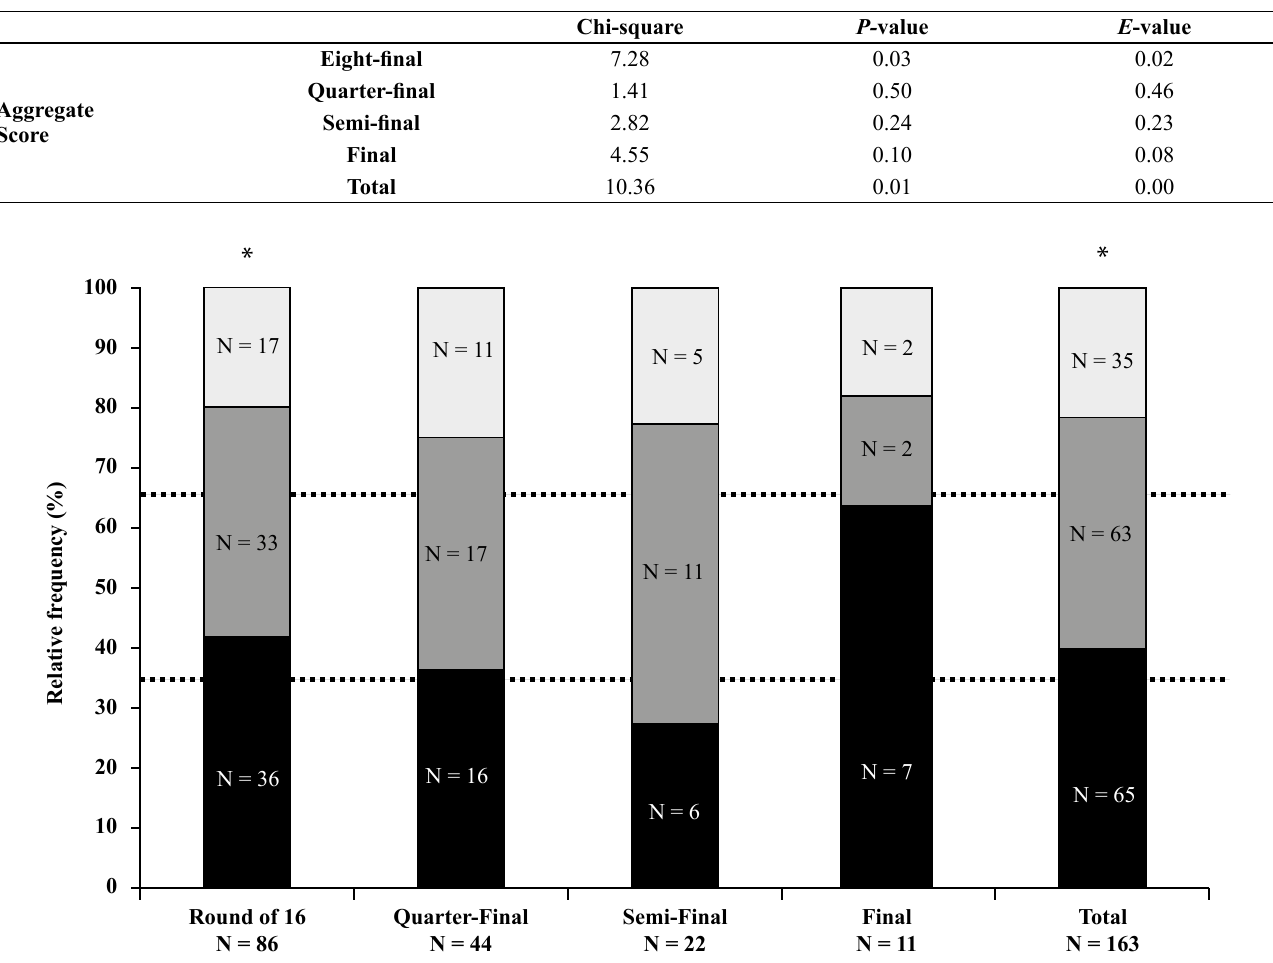
Figure 1. Home (black box), draw (dark grey box) and away (light grey box) results in the second-leg home advantage concept concerning the aggregate final result. Table 2. Chi-square statistic (P-value), Full Bayesian Significance Tests (E-value), probability occurrence (p1<1/2) for the comparison